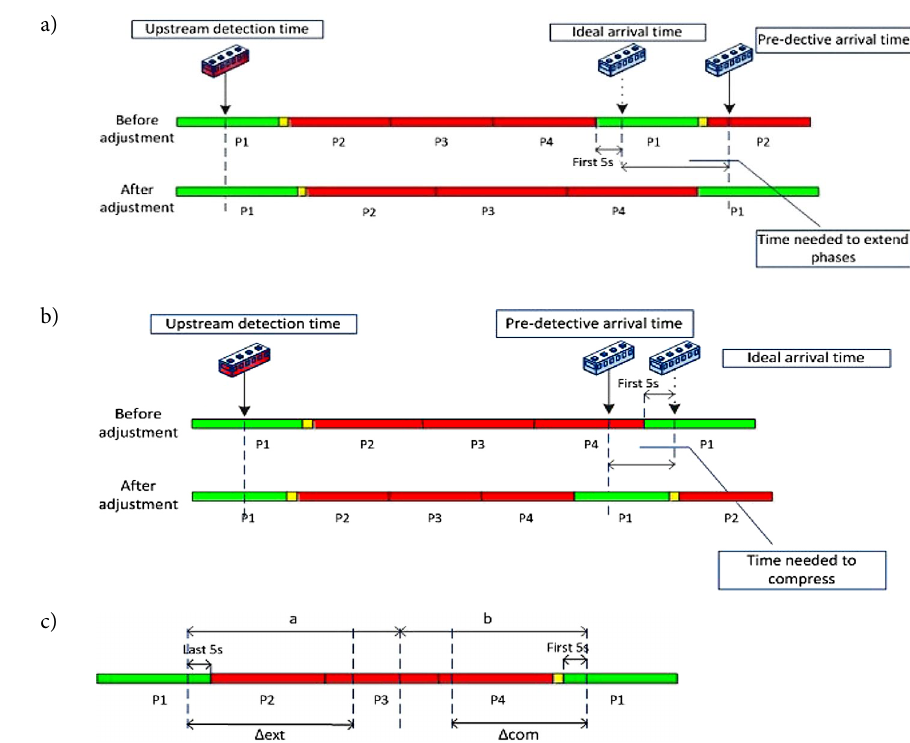
Fig. 2. Extension option (a), compression option (b) and sketch map of minimal expected